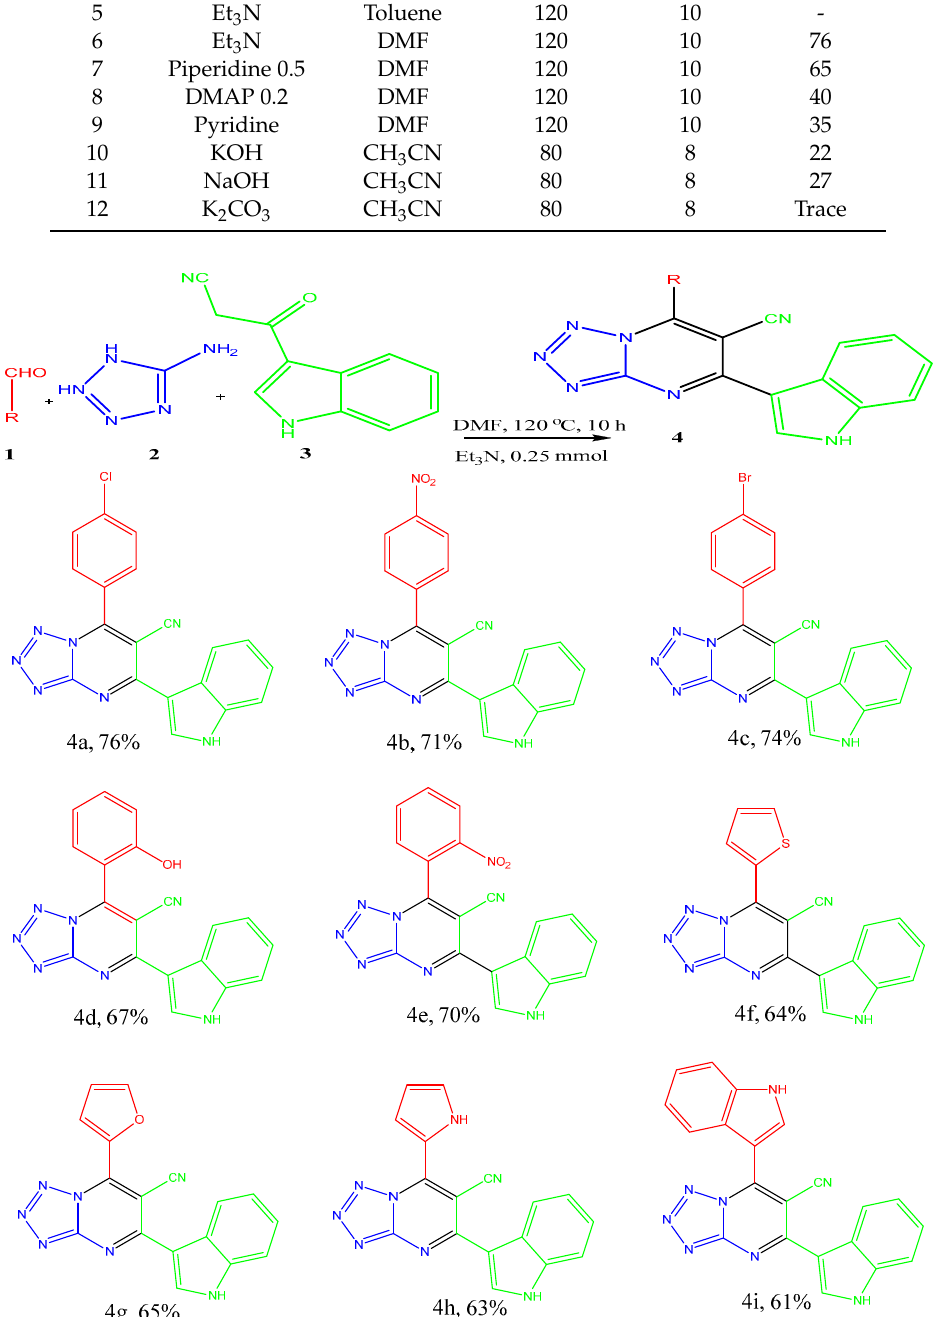
Figure 2. Multi-component synthesis of 7-substituted-5-(1 H -indol-3- yl )tetrazolopyrimidine-6-carbonitrile. Reaction conditions: aldehyde 1 (1 mmol), 1 H -tetrazole-5-amine 2 (1 mmol), 3-cyanoacetyl indole 3 (1 mmol), Et 3 N (0.25 mmol), in dimethylformamide (DMF) at 120 °C, and about 10 h reaction time.